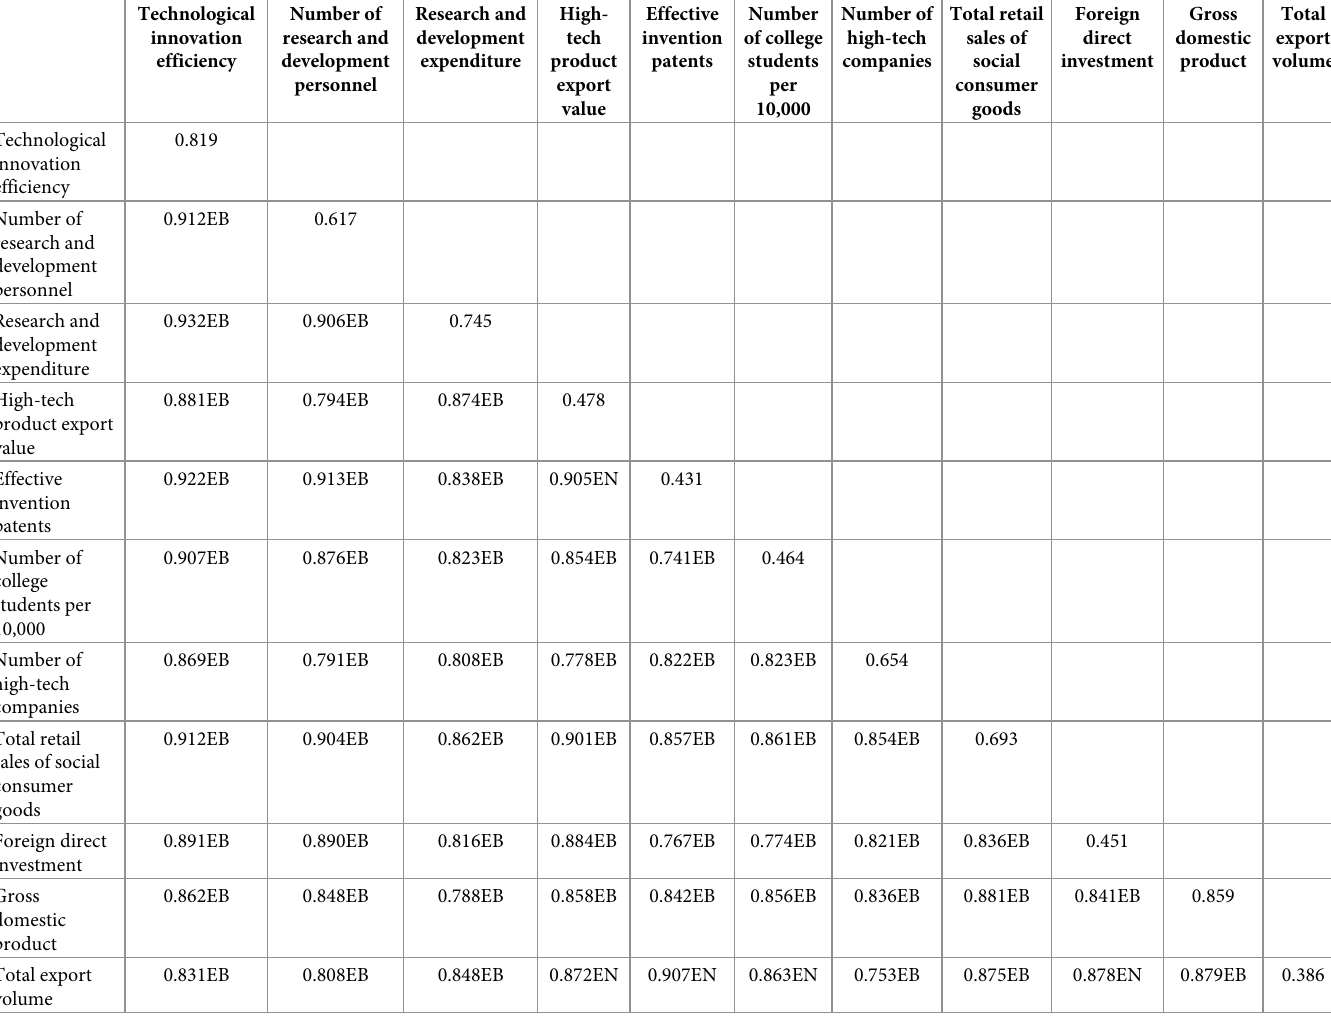
Table 6. Factors influencing the degree of coupling between provincial high-tech industry and regional economic composite